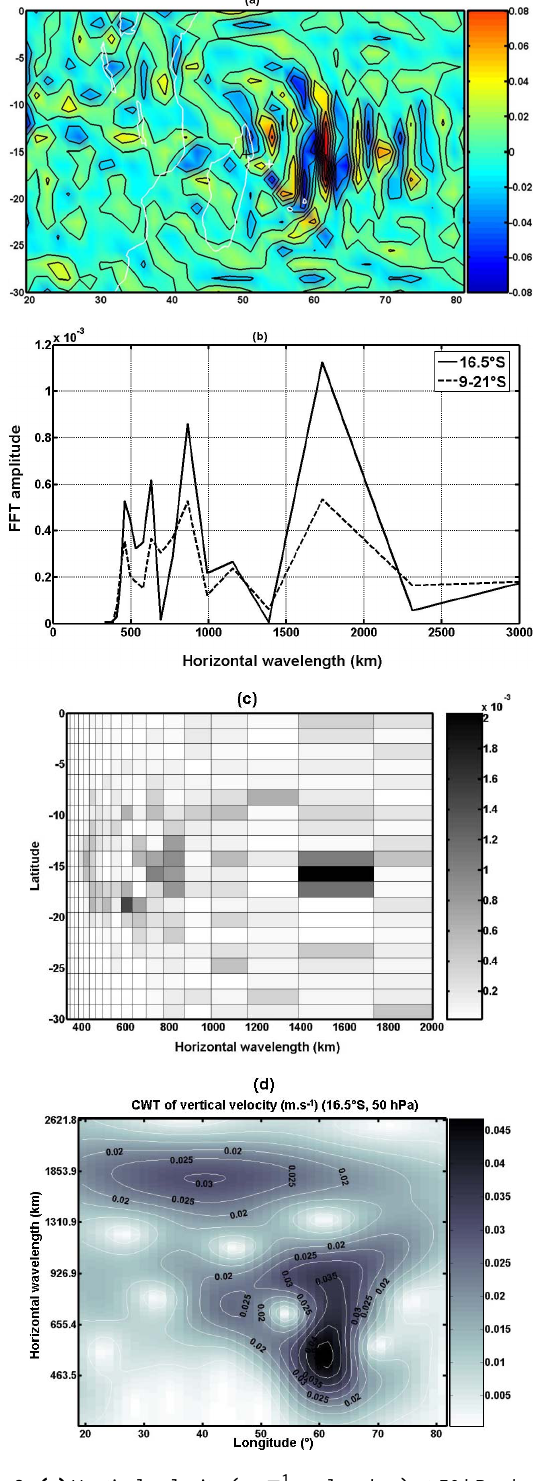
Fig. 8. (a) Vertical velocity (ms − 1 , colour bar) at 50hPa derived from ECMWF analyses on 16 February 2008 (00:00UTC). The black (white) cross shows the centre of the semi-circular waves (TC Ivan). Fast Fourier transform of vertical velocity (b) at latitudes of 16.5 ◦ S and 9–21 ◦ S and (c) as a function of latitude. (d) Morlet continuous wavelet transform of vertical velocity at 16.5 ◦